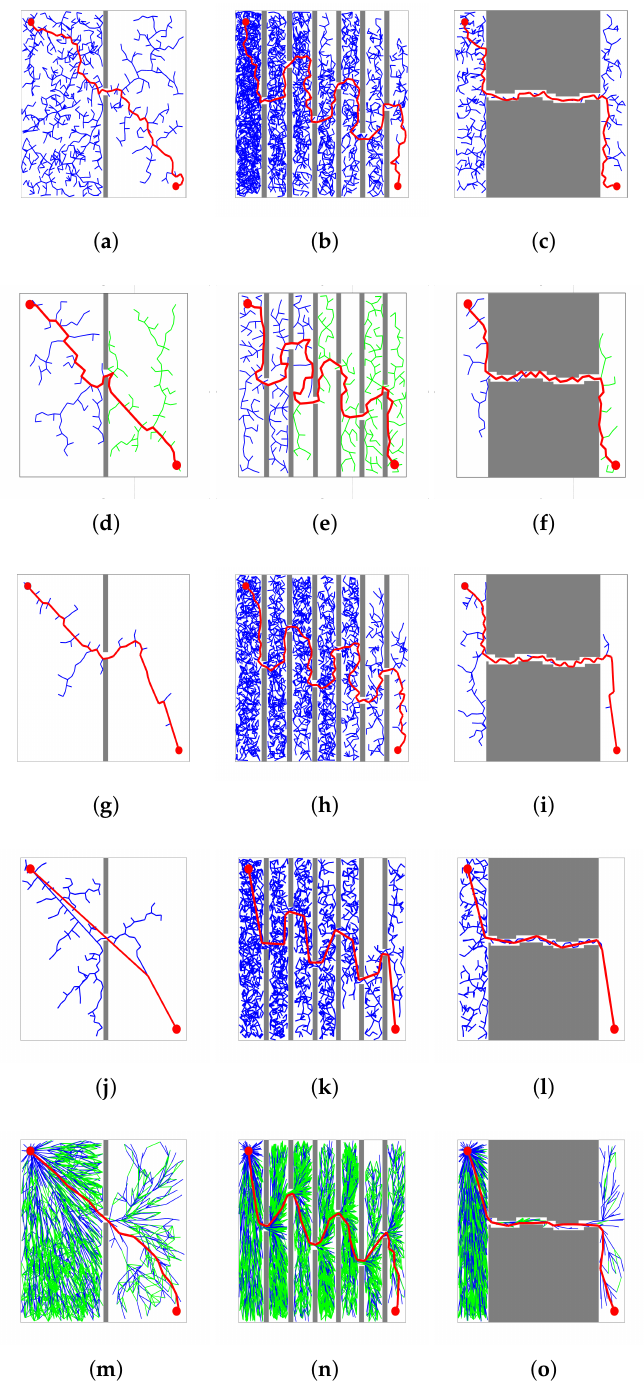
Figure 10. ( a – c ) show the path planning results of RRT in three maps; ( d – f ) are the path planning results of RRT-Connect in three maps; ( g – i ) are the path planning results of P-RRT in three maps; ( j – l ) are the path planning results of 1-0 Bg-RRT in three maps; and ( m – o ) are the path planning results of RRT ∗ in three maps. The red line corresponds to the final